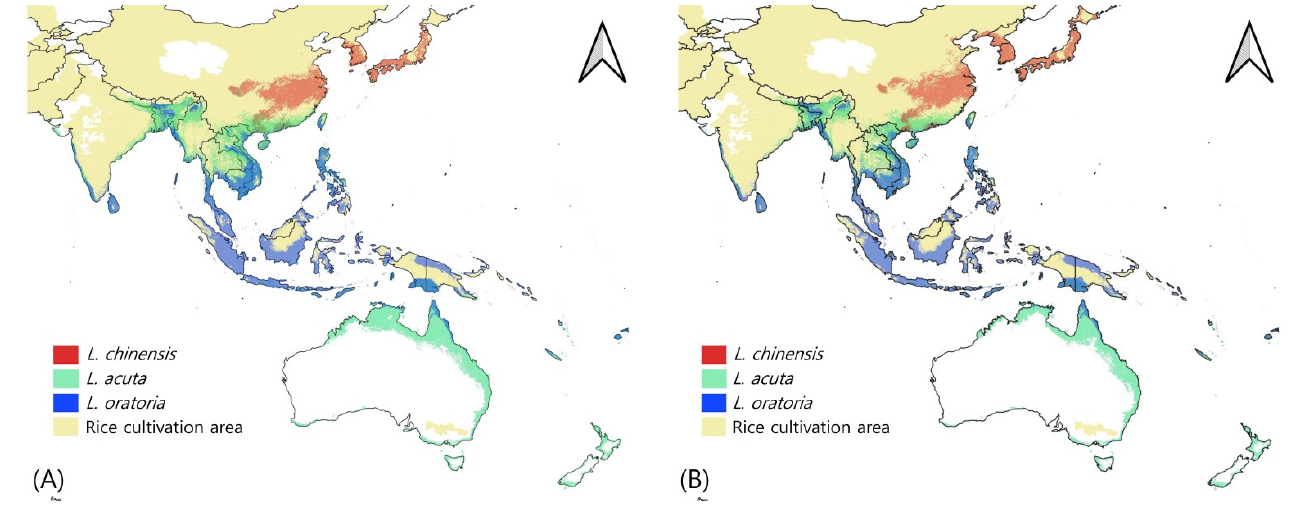
Figure 5. Integrative potential distribution of three Leptocorisa species with rice cultivation area ( A ) under current climate, and ( B ) for 2081–2100.